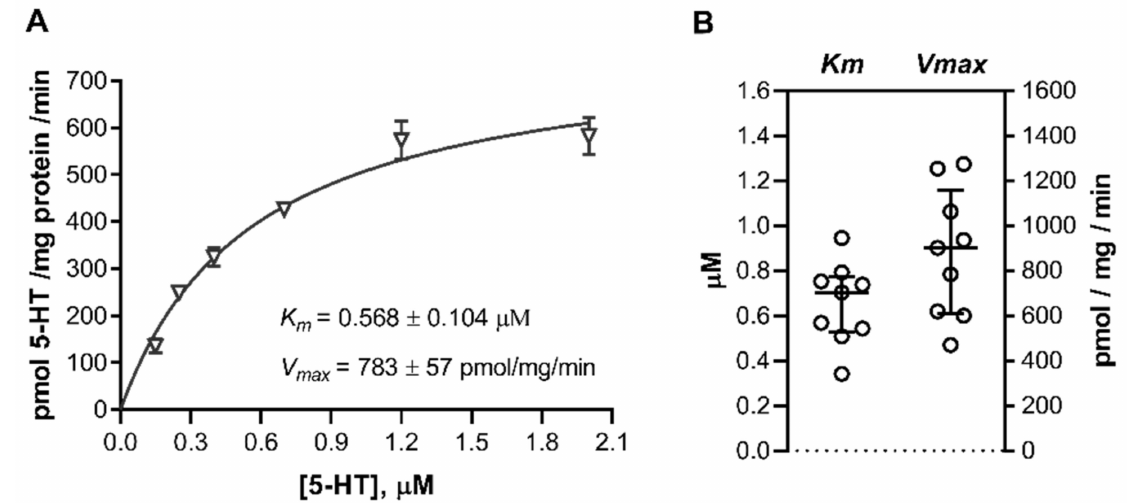
Figure 5. Uptake of 5-HT into human cord blood platelets. Platelets were isolated from cord blood samples and incubated for 1 min in the presence of six increasing concentrations (0.15 to 2.00 µ M) of radiolabeled 5-HT. The specific transport was determined as the difference between transport at 37 ◦ C and at approximately 4 ◦ C (ice bath). ( A ) Initial rates of specific uptake of 5-HT were plotted against the substrate concentration and fitted to the Michaelis–Menten kinetics model. Shown are data (means ± SD) from one of nine subjects studied. ( B ) Best-fit values of the Michaelis affinity constant ( Km ) and maximal transport velocity ( Vmax ). Circles show individual values obtained in cord blood platelets isolated from different subjects (n = 9); lines represent medians and interquartile range. For numerical data, see Table